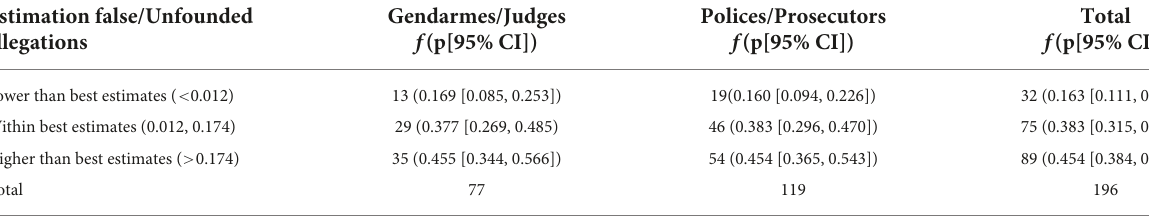
TABLE 2 Contingency table of grouping estimates and population. Estimation